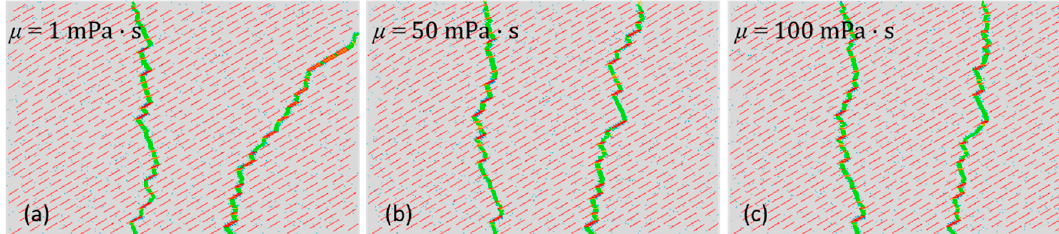
Figure 14. Effect of viscosity on hydraulic fracture propagation. ( a ) Fluid viscosity = 1 mPa · s; ( b ) fluid viscosity = 50 mPa · s; ( c ) fluid viscosity = 100 mPa · s.